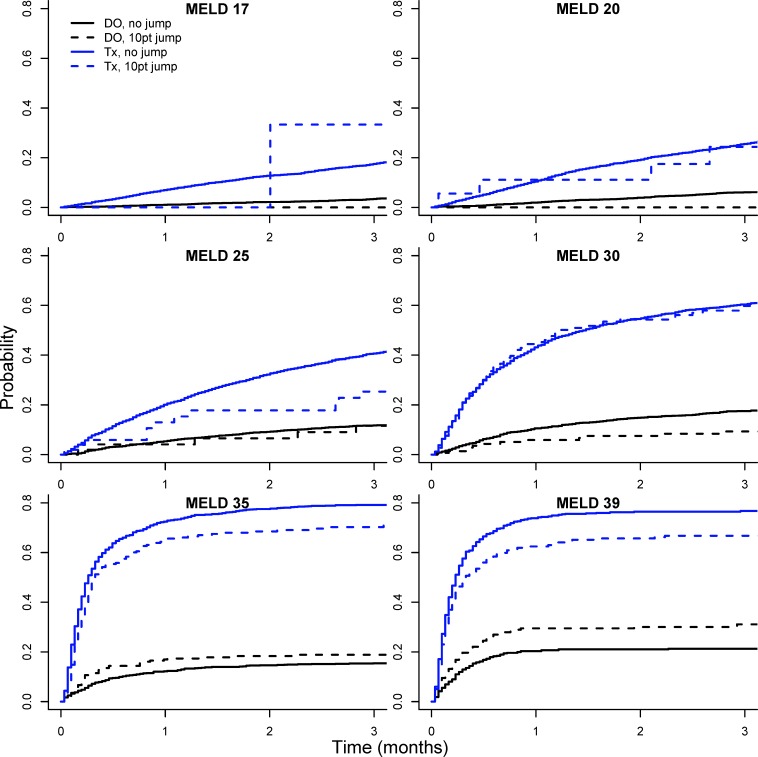
Cumulative incidence curves for waitlist dropout (DO) and transplantation (Tx) in data post MELD-Na and Share 35.Cumulative incidence curves for waitlist dropout (black lines) and transplantation (blue lines) for patients with (dashed line) and without (solid line) a ΔMELD30 ≥ 10 jump at various MELD scores. Based on UNOS/OPTN data for registrants on the liver transplant waitlist between 01/02/2016 to 09/07/2018.